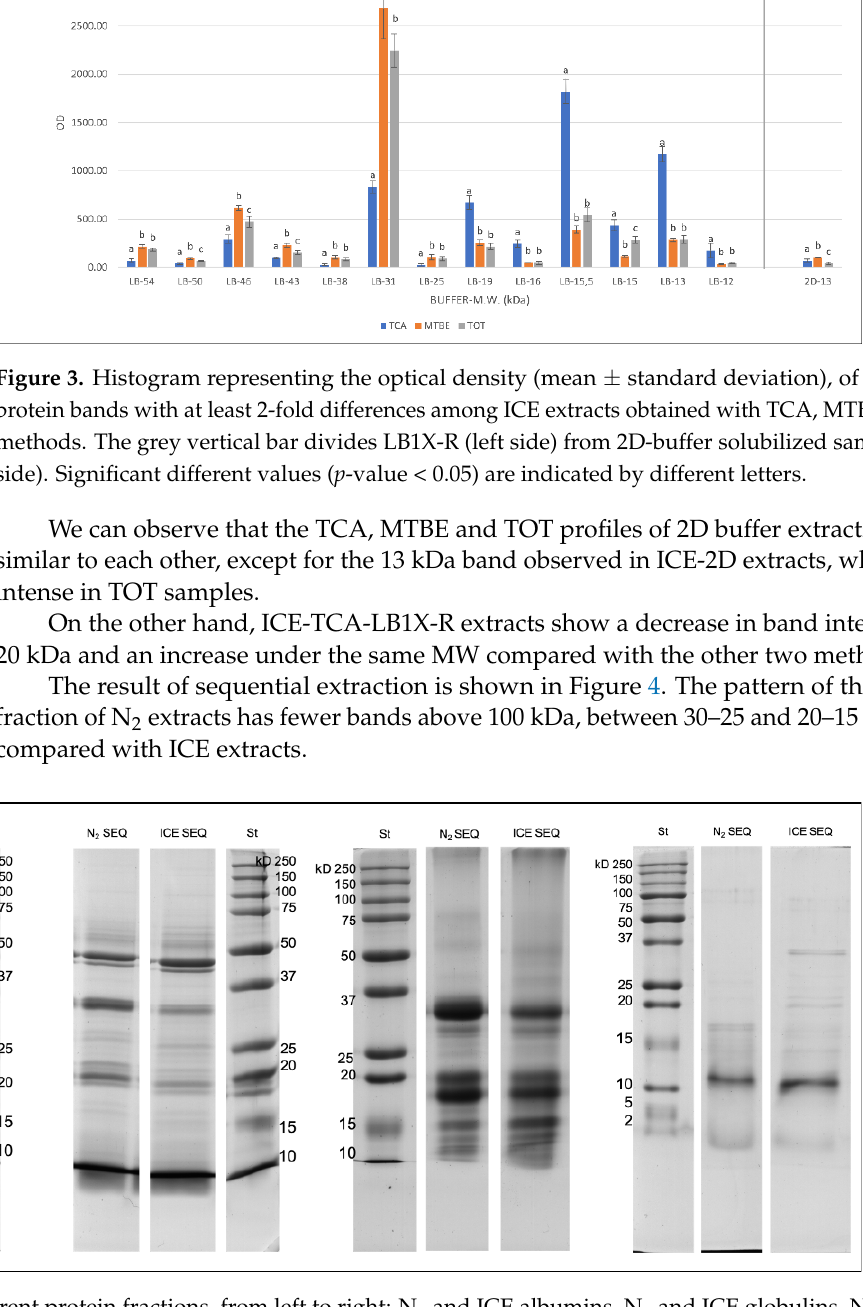
Figure 3. Histogram representing the optical density (mean ± standard deviation), of SDS-PAGE protein bands with at least 2-fold differences among ICE extracts obtained with TCA, MTBE and TOT methods. The grey vertical bar divides LB1X-R (left side) from 2D-buffer solubilized samples (right side). Significant different values ( p -value < 0.05) are indicated by different letters.